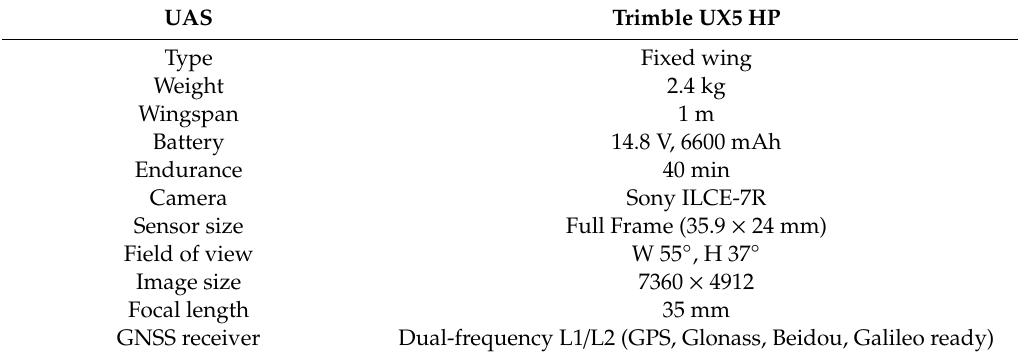
Table 2. Technical characteristics of Trimble UX5 HP Unmanned Aerial System (UAS) used in this